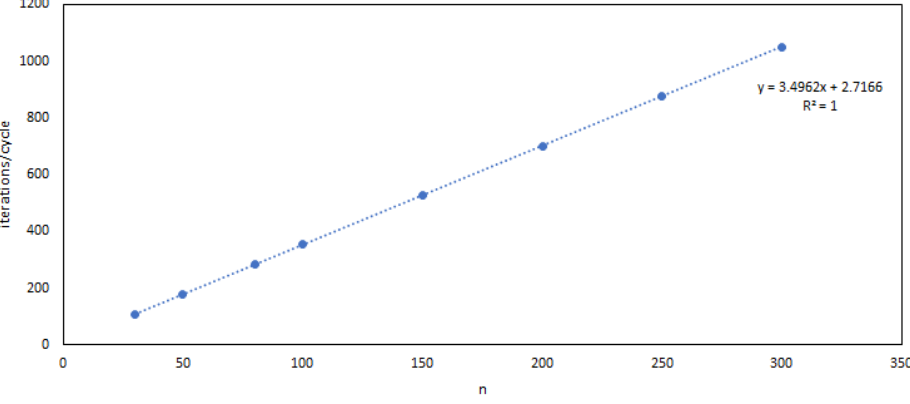
Figure 4. Expected number of iterations per cycle, as a function of space dimension n . Trend-line equation with R 2 value, displayed by